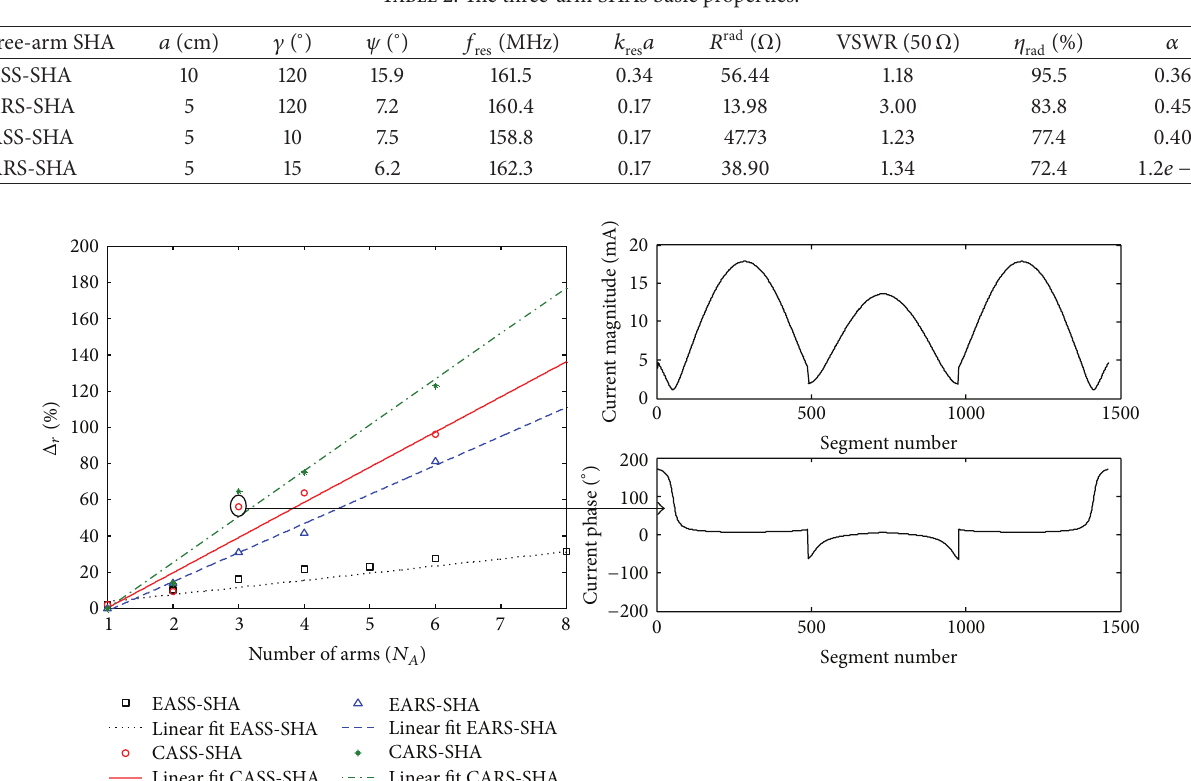
Table 2: The three-arm SHAs basic properties.